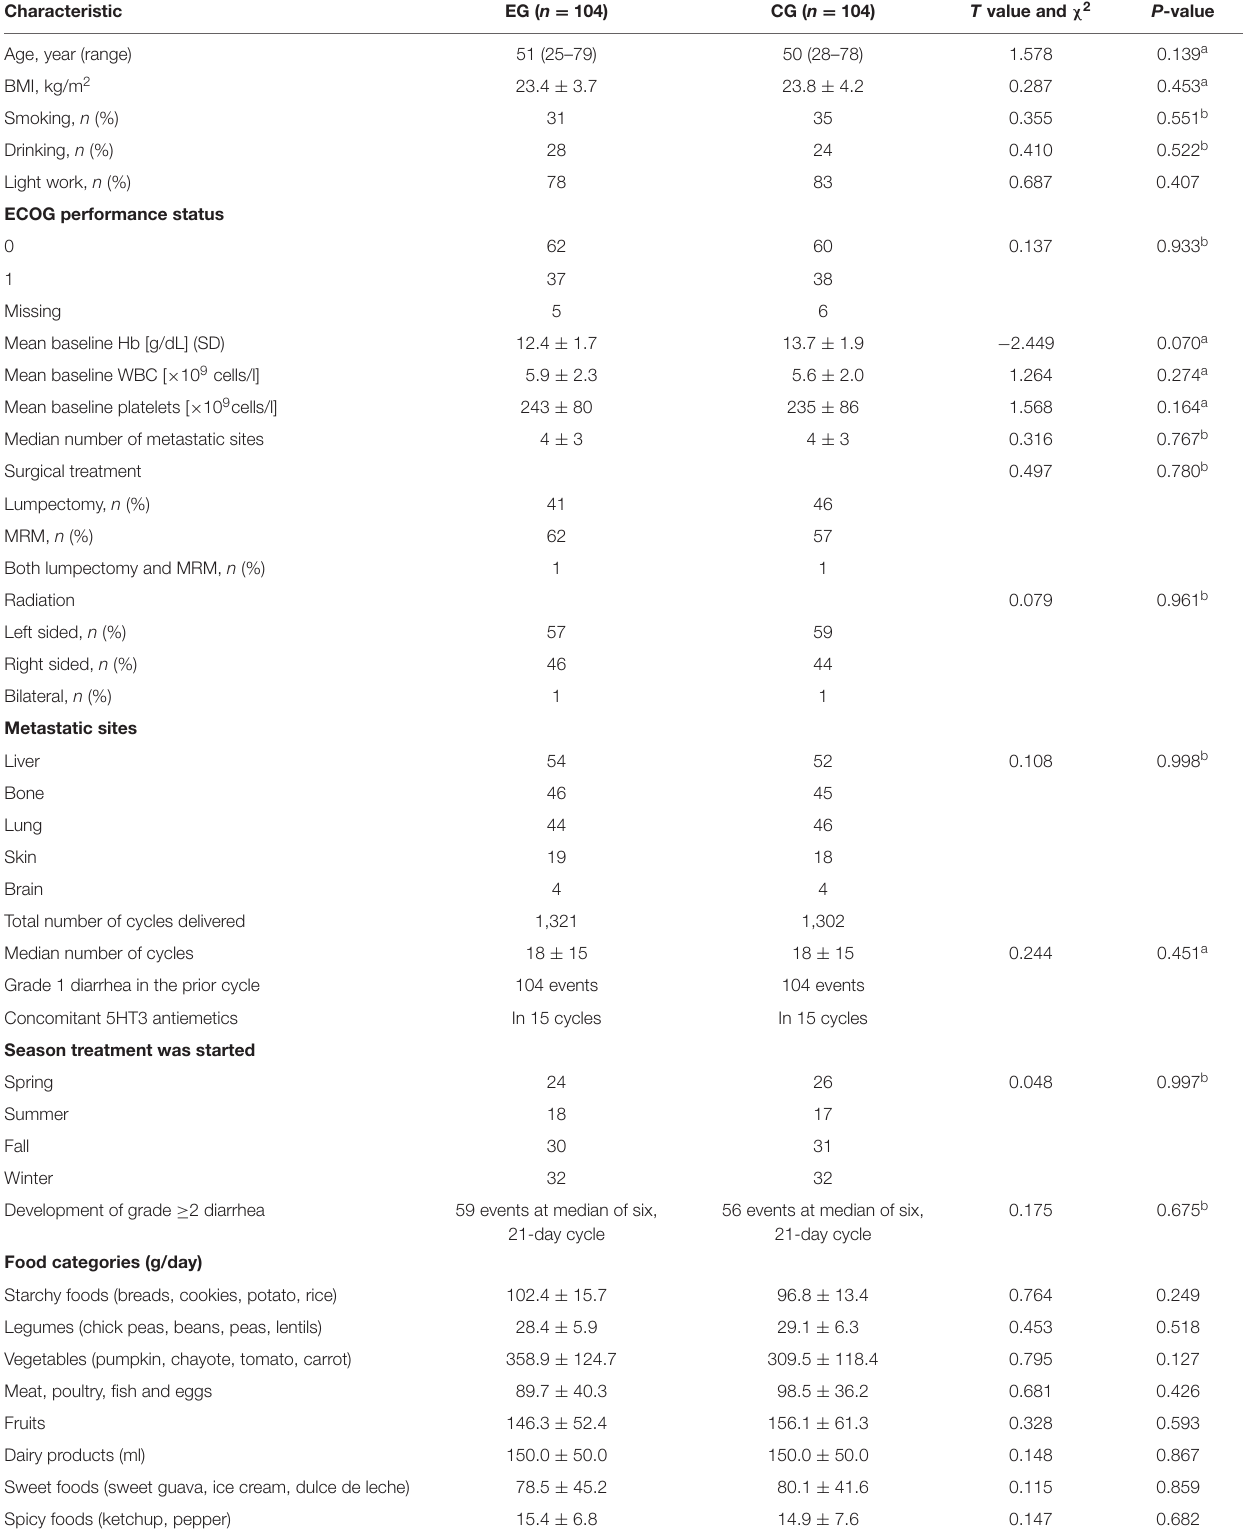
TABLE 3 | Characteristics of patients and treatment